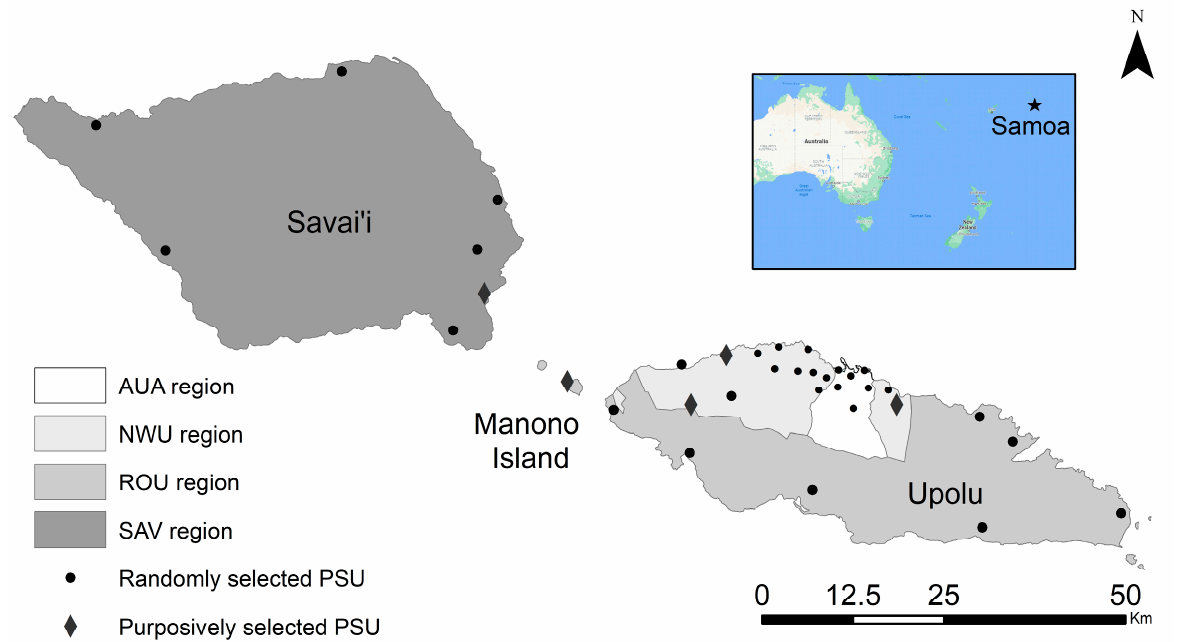
Figure 1. Map of Samoa showing approximate locations of the 35 primary sampling units (PSUs). Villages included in each PSU are given in Supplementary Figure S1.1. Spatial data on country, island, region, and village boundaries in Samoa were obtained from the Pacific Data Hub